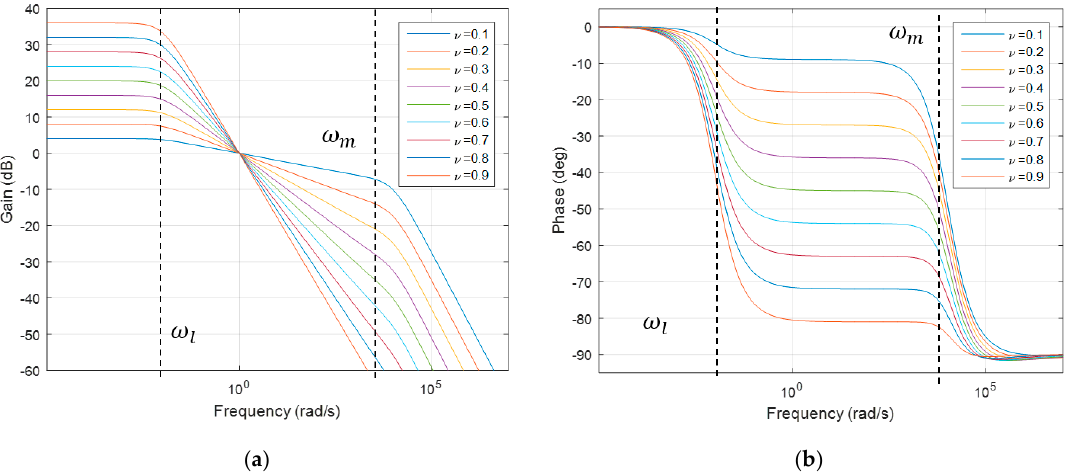
Figure 5. Frequency response (gain on the ( a ), phase on the ( b )) of I(s) with the non-singular kernel η ( t ) for ν varying from 0.1 to 0.9 and with ω l = 10 − 2 rd / s, ω m = 10 4 rd /